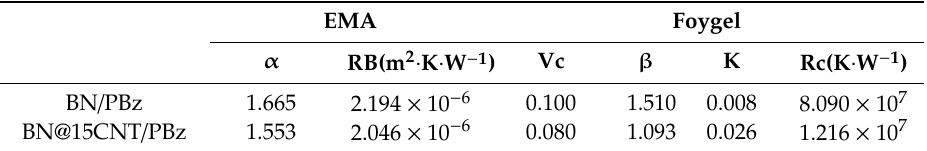
Table 4. Fitted parameters of λ values of BN / PBz and BN@15CNT / PBz composites with the EMA model and Foygel’s